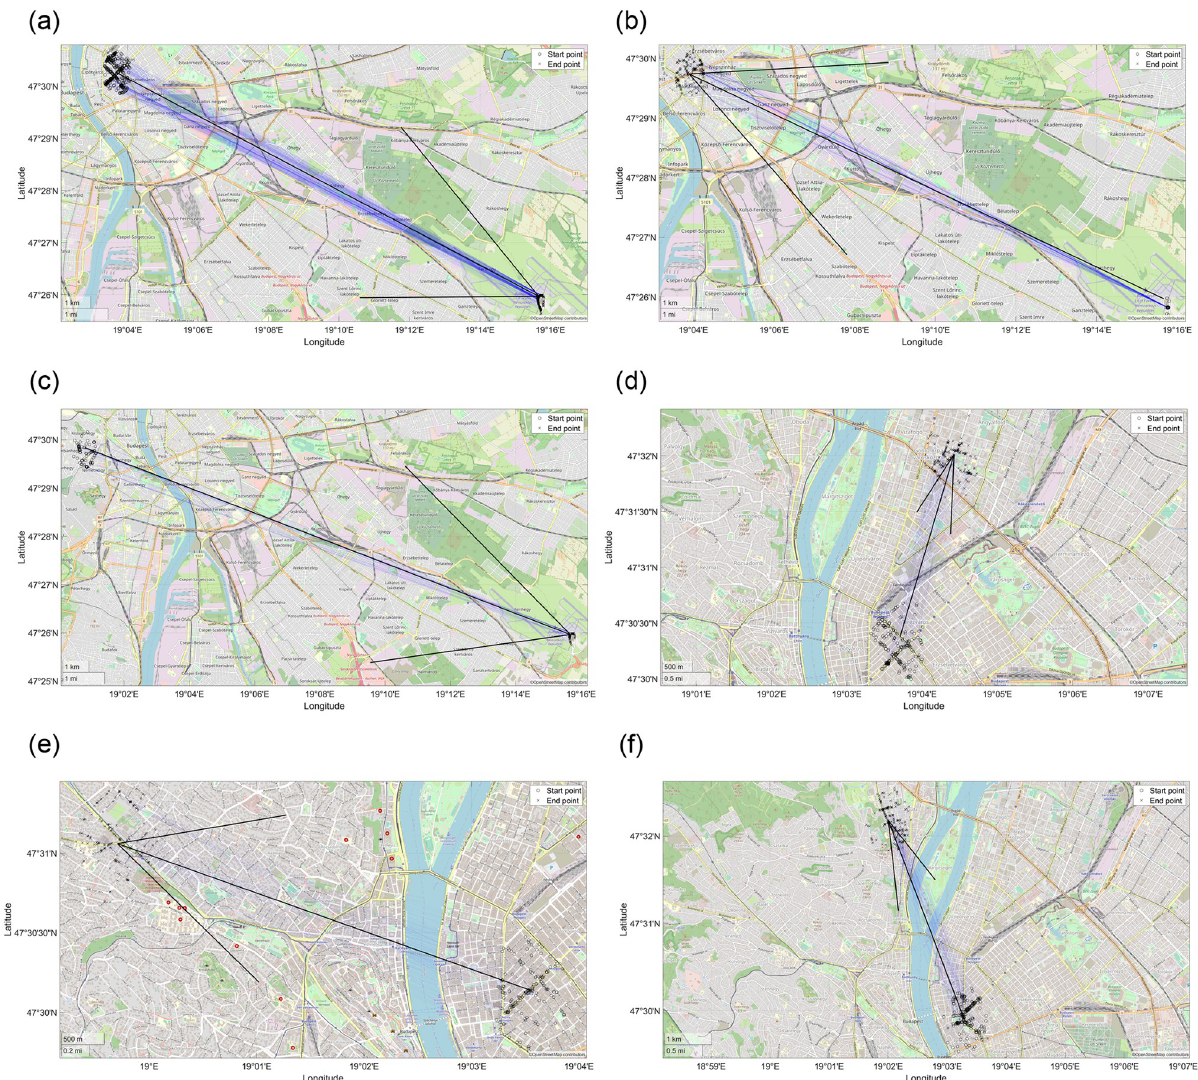
Fig 6. Exemplary clusters, where the start and endpoints points of the individual rides in the cluster are represented by yellow dots and black crosses, respectively. The cluster centroids, marked by the start and end point of the arrow, point from one public transport stop to another.